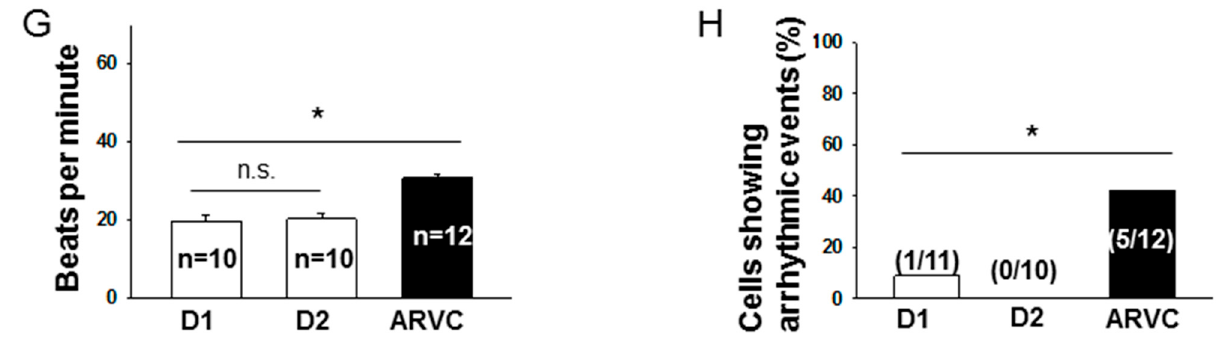
Figure 2. SK4 channel currents, and beating frequency and occurrence rate of arrhythmic events, were higher in ARVC-hiPSC-CMs than in donor cells. SK4 channel currents (I SK4 ) were measured in whole-cell configuration in healthy donor (D1, D2) or ARVC cells depolarized from − 80 mV to + 80 mV for 400 ms with a holding potential of − 40 mV. TRAM-34 (1 µ M, A – C , E , F ) and clotrimazole (3 µ M, D ), SK4 channel blockers, were used to separate I SK4 from other ion channel currents. For assessing the pacemaker activity and arrhythmic events (early or delayed afterdepolarizations or triggered beats), spontaneous action potentials (sAPs) were recorded in current-clamp mode. ( A – C ) The current-voltage relation (I-V) curves of I SK4 (TRAM-34-sensitive currents) in hiPSC-CMs from donor one (D1, A ), donor two (D2, B ) and the ARVC-patient (ARVC, C ) with 500 nM Ca 2 + (Ctr) or without Ca 2 + (Ca 2 + -free) in the pipette solution. ( D ) I–V curves of clotrimazole-sensitive currents in donor-hiPSC-CMs (D1 cells). Of note, some I–V curves in A-D contain small inward currents, which changed the reverse potential of curves. ( E , F ) Comparison of I SK4 between donor and ARVC cells showing increased I SK4 in ARVC-hiPSC-CMs. ( G ) Frequency of sAPS in donor and ARVC cells showing enhanced pacemaker activity in ARVC-hiPSC-CMs. ( H ) Percentage of cells showing arrhythmic events in donor and ARVC cells. * p < 0.05; n.s., not significant. The numbers given represent cell numbers.